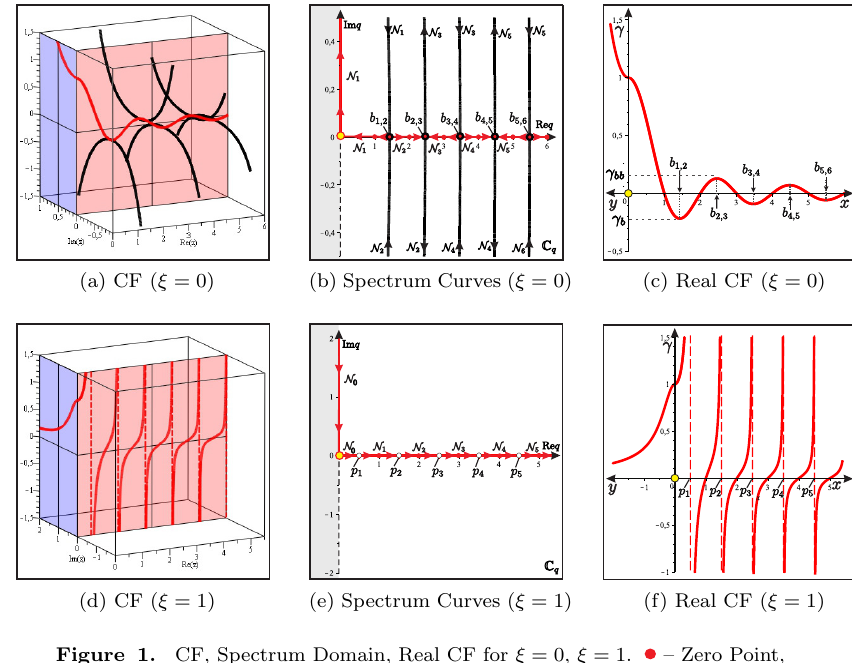
Figure 1. CF, Spectrum Domain, Real CF for ξ = 0, ξ =